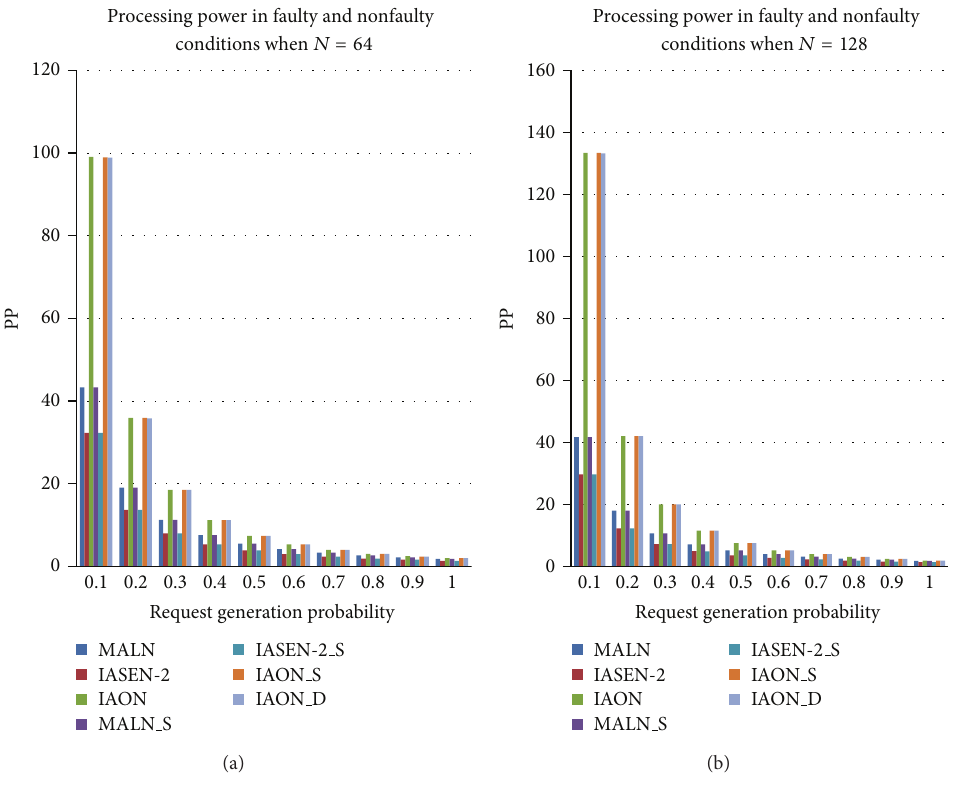
Figure 15: The processing power of MALN, IASEN-2, and IAON in faulty and nonfaulty cases, when the network sizes are 64 and 128